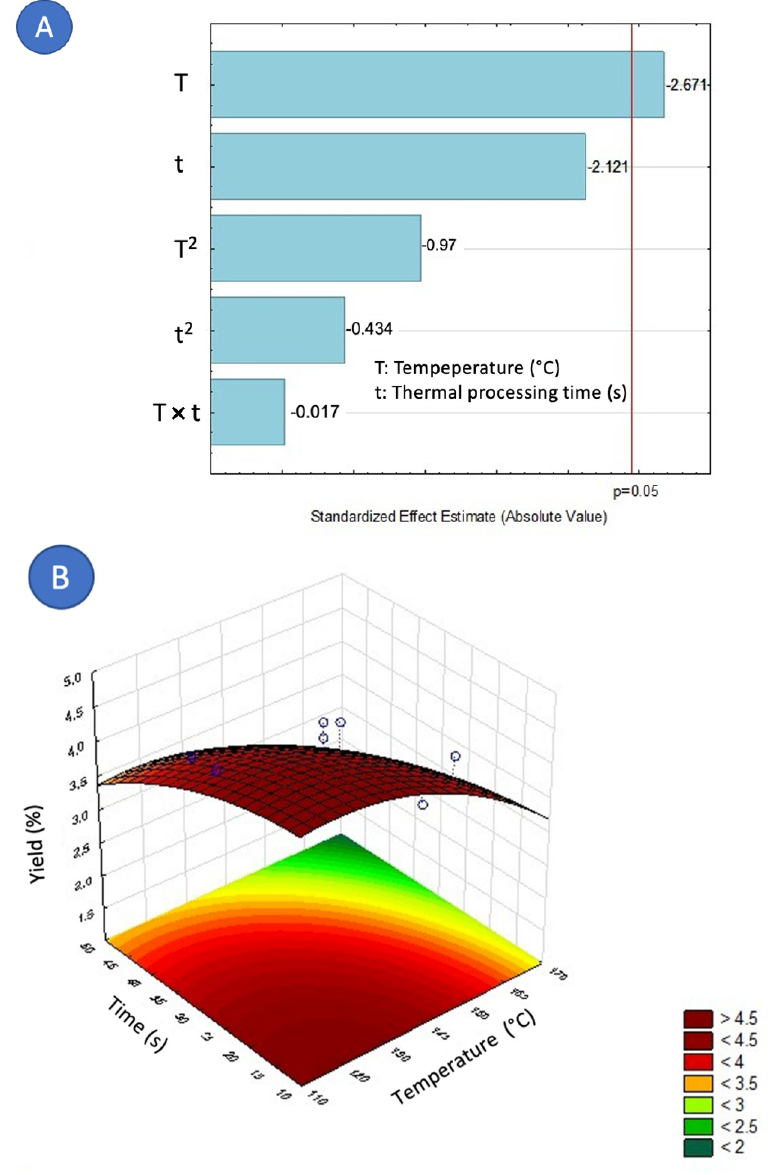
Figure 2. Effect of steam processing temperature “T” (°C) and thermal processing time “t” (s) on yield (%) of EO: ( A ) Pareto chart ( B ) Surface response.